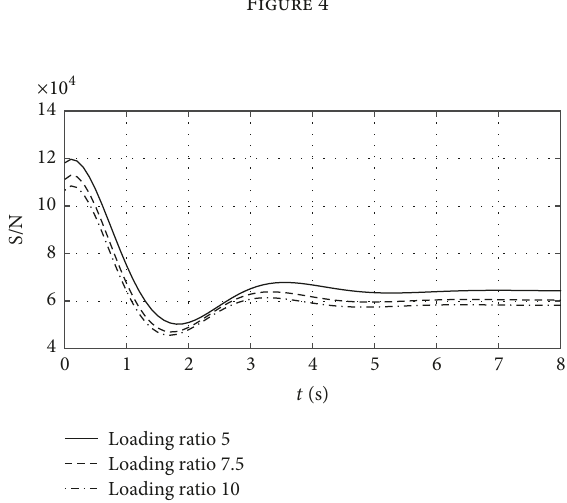
Table 1: Overshoot for different damping coefficients.